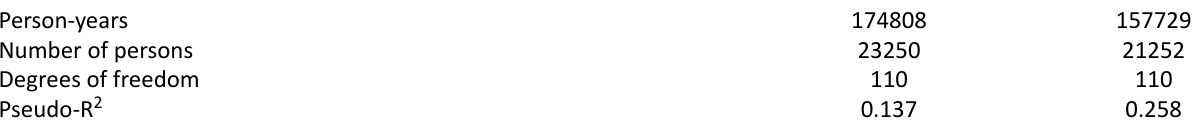
Women Men Coef./(se)